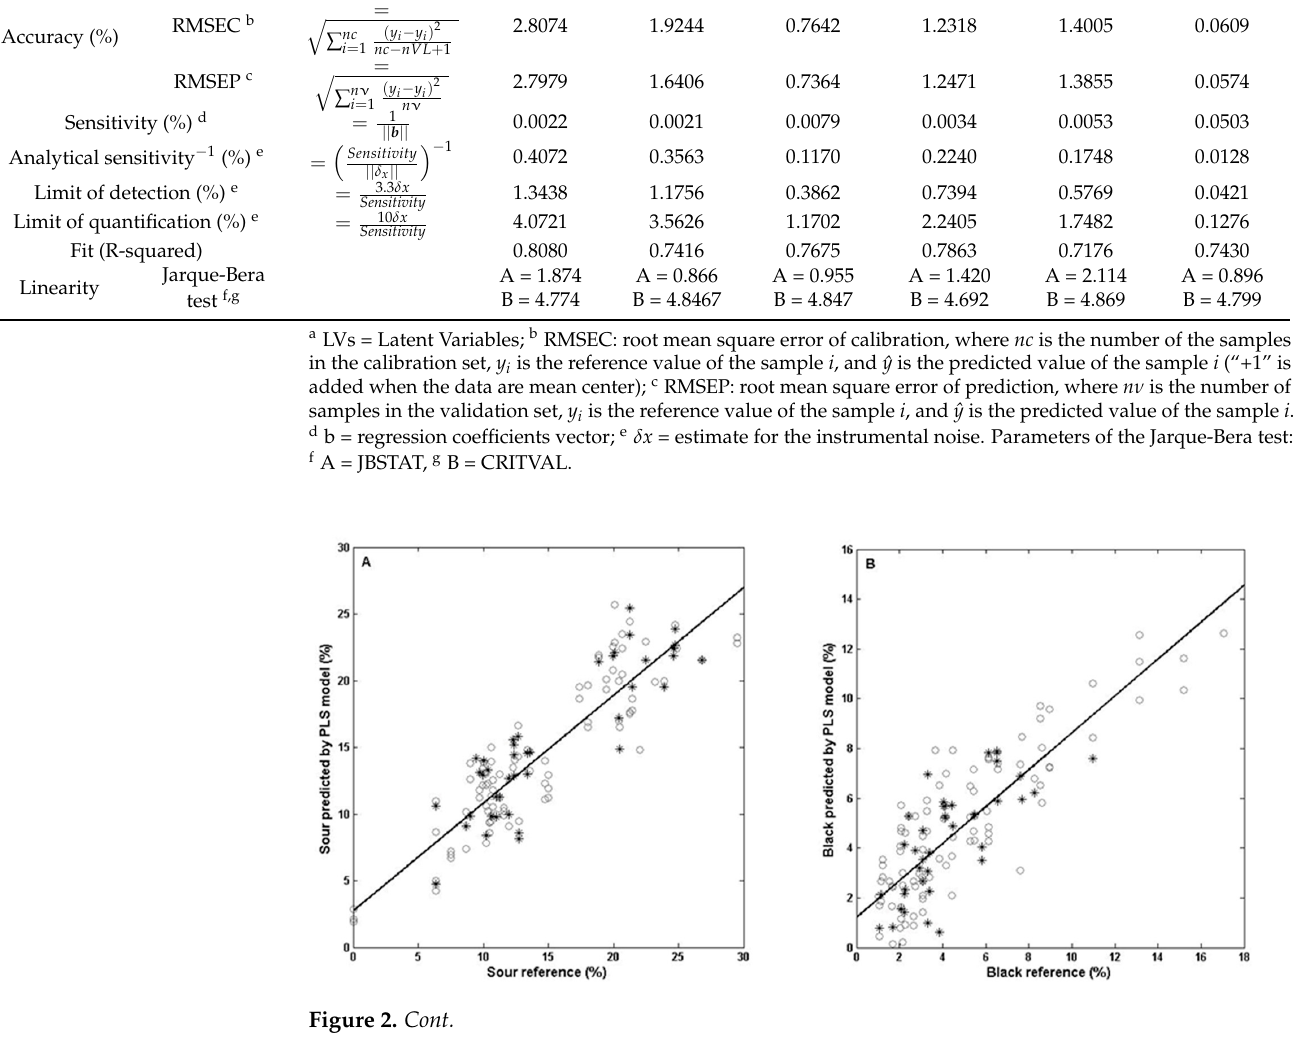
Figure 2. Adjustment (after the elimination of outliers). Reference values against values predicted by the PLS models: ( A ) sour; ( B ) black; ( C ) skin; ( D ) whole; ( E ) broken; and ( F ) woods. ( ο ) Calibration samples and ( ∗ ) validation samples. Sensitivity corresponds to the fraction of the analytical signal due to increasing the level of a particular analyte by a unit concentration. Considering inverse multivariate